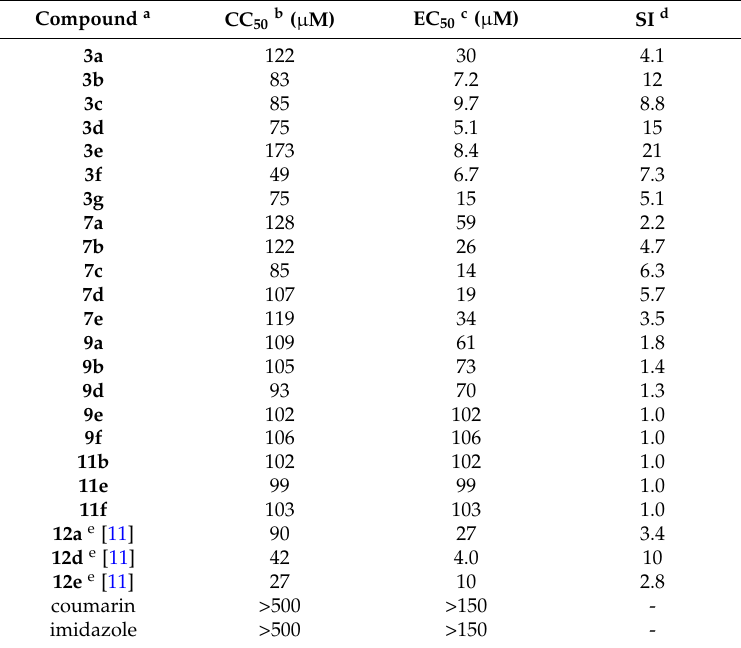
Table 1. Anti-metabolic and antiviral effect of conjugated compounds on HCV 1b subgenomic replicon replication in Huh 5-2